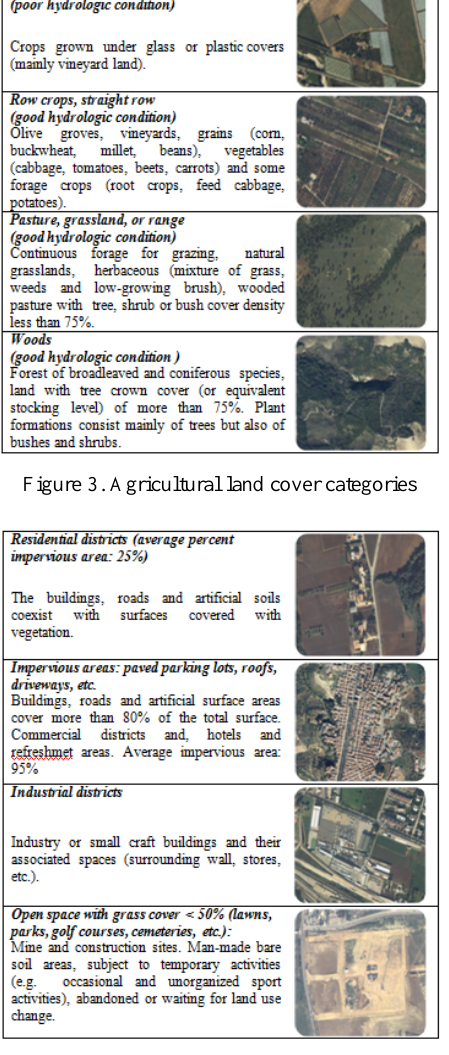
Figure 4. Urban land cover